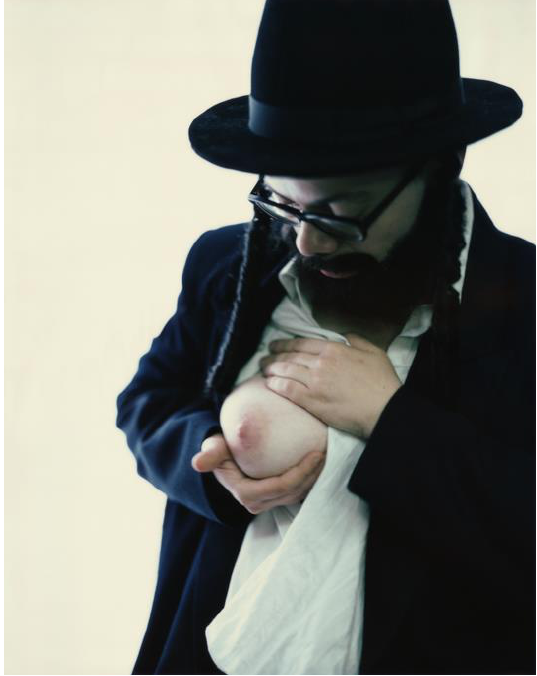
Figure 4 . Oreet Ashery, Self Portrait as Marcus Fisher II , 2000, original 25.4 × 20 cm; Polaroid scanned to lambda prints, 100 × 110 cm. Photograph by Manuel Vason. Courtesy of the artist.